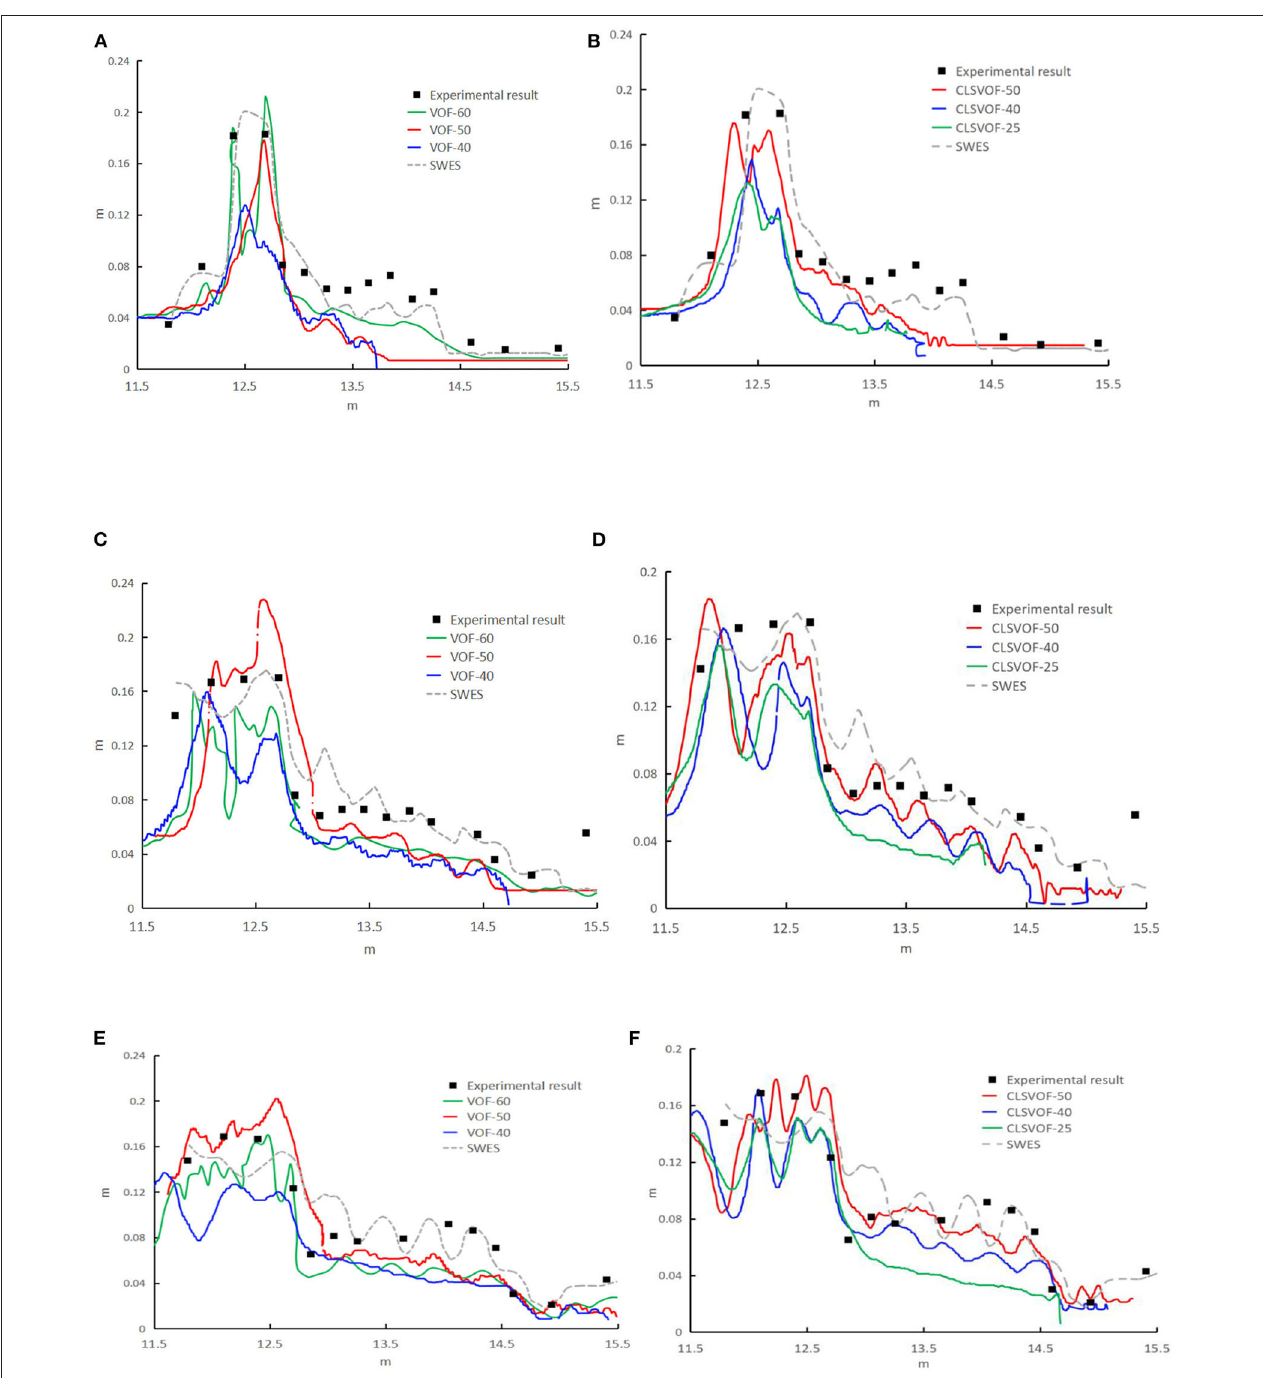
FIGURE 2 | The free surface profile at different time in Section B-B (A,B) t